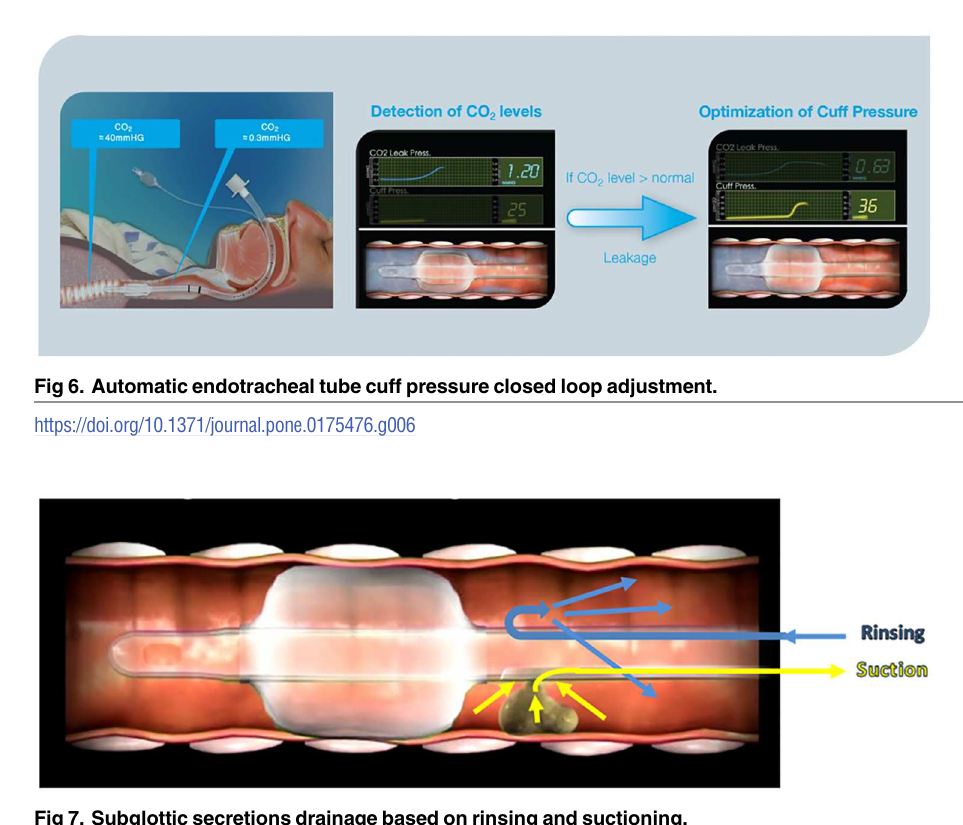
Fig 7. Subglottic secretions drainage based on rinsing and